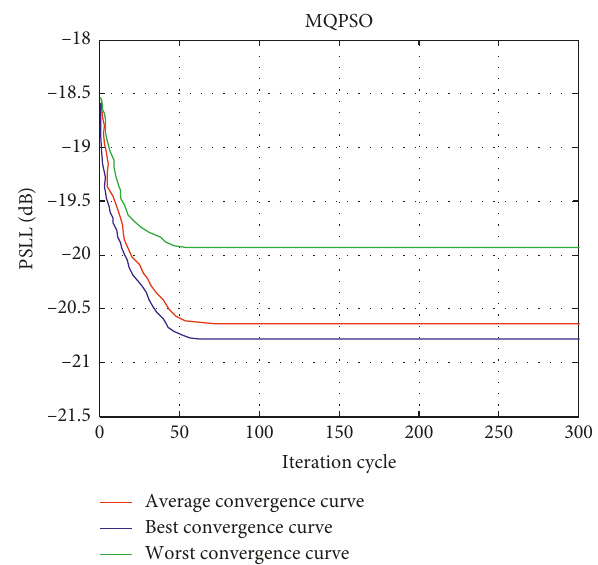
Figure 9: Convergence curve of fitness function. MQPSO for Example 2 optimization.